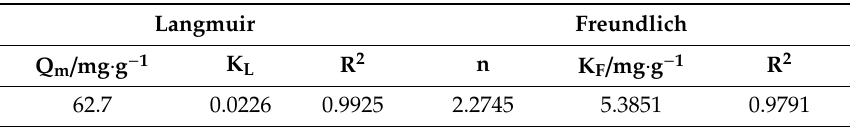
Table 3. Adsorption capacity of various adsorbents for aniline